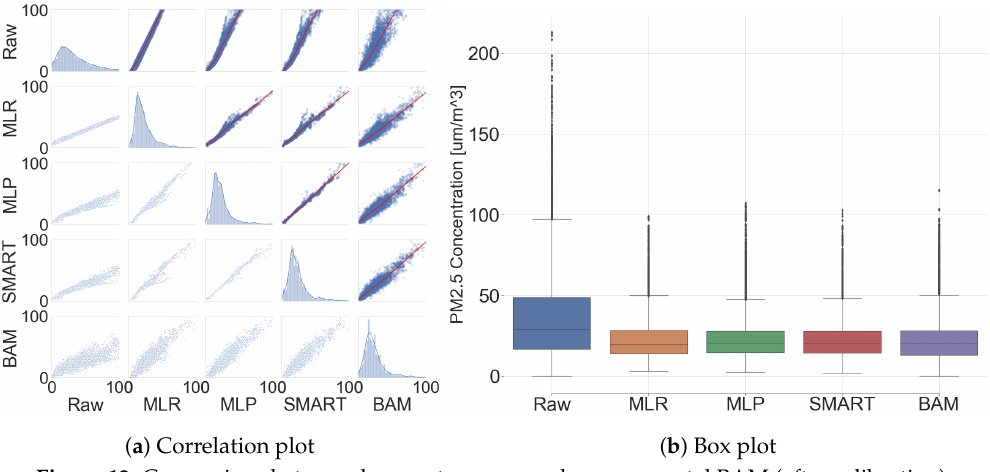
Figure 12. Comparison between low-cost sensors and governmental BAM (after calibration).